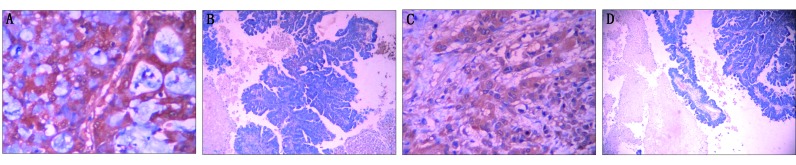
TSG101 and PEG10 expression in AC using EnVision immunohistochemistry; original magnification, ×200. TSG101- and PEG10-positive reactions were mainly localized in the cytoplasm. (A) Positive TSG101 expression (>25% positive cells) in poorly-differentiated AC. (B) Negative TSG101 expression (<25% positive cells) in well-differentiated AC. (C) Positive PEG10 expression in poorly-differentiated AC. (D) Negative PEG10 expression in well-differentiated AC. TSG101, tumor susceptibility gene 101; PEG10, paternally expressed gene 10; AC, adenocarcinoma.